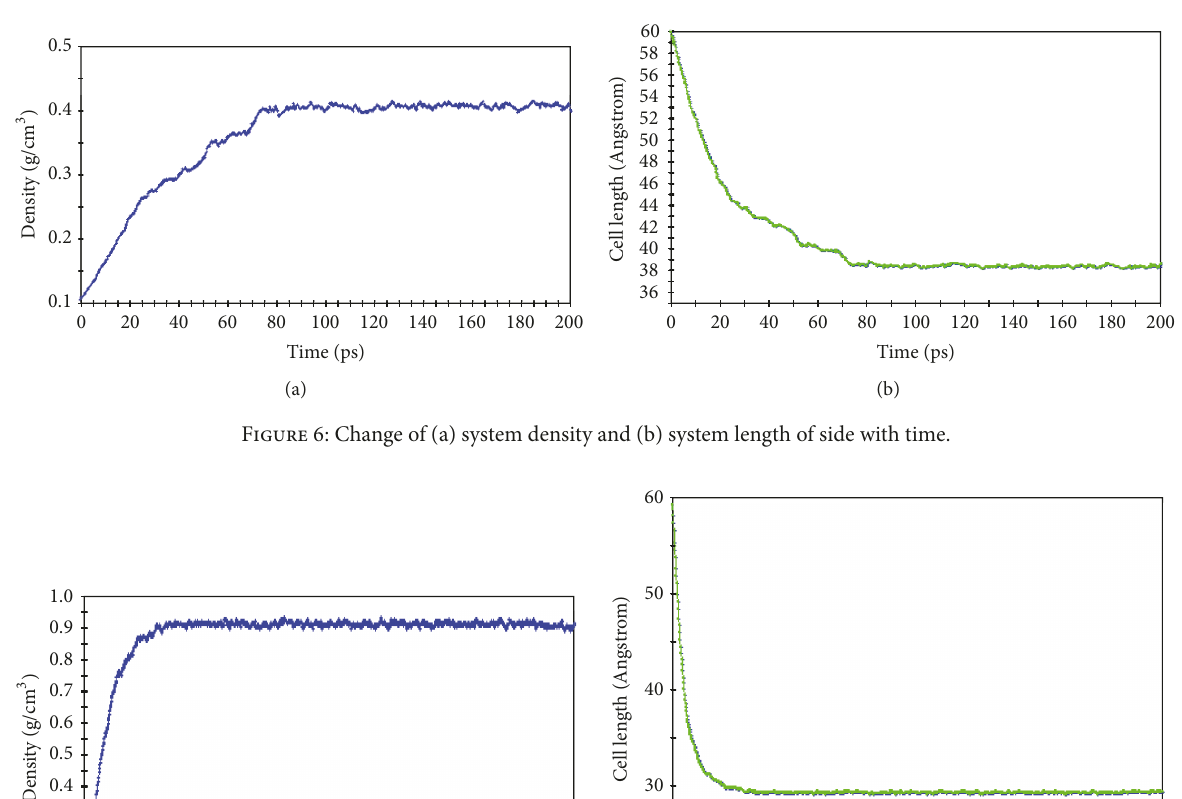
Figure 5: Change of system energy with simulation time.